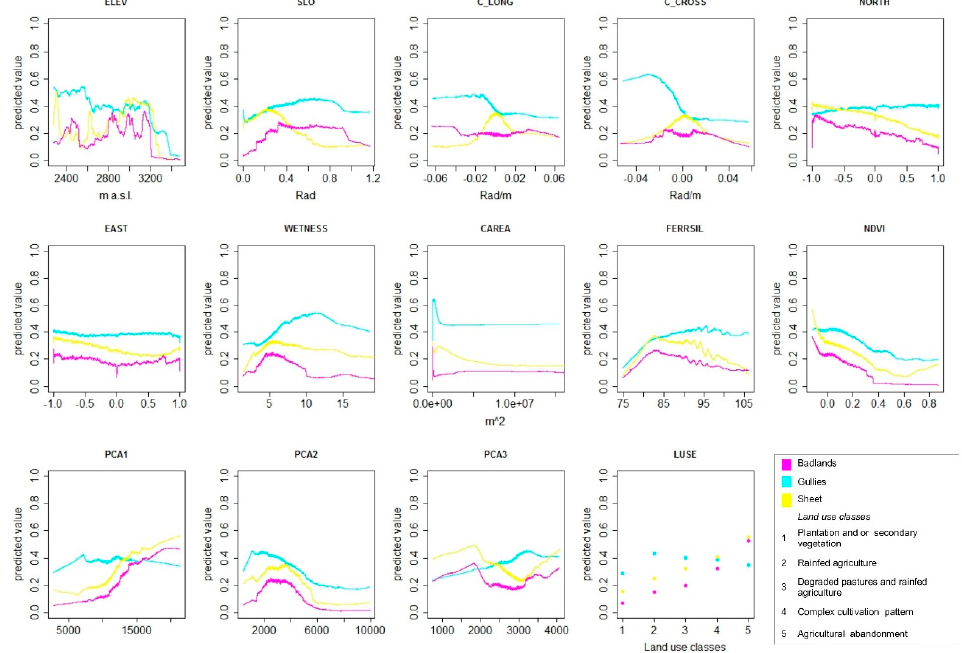
Figure 5. Response curves for the predictive models for Badlands, gullies, and sheeting.